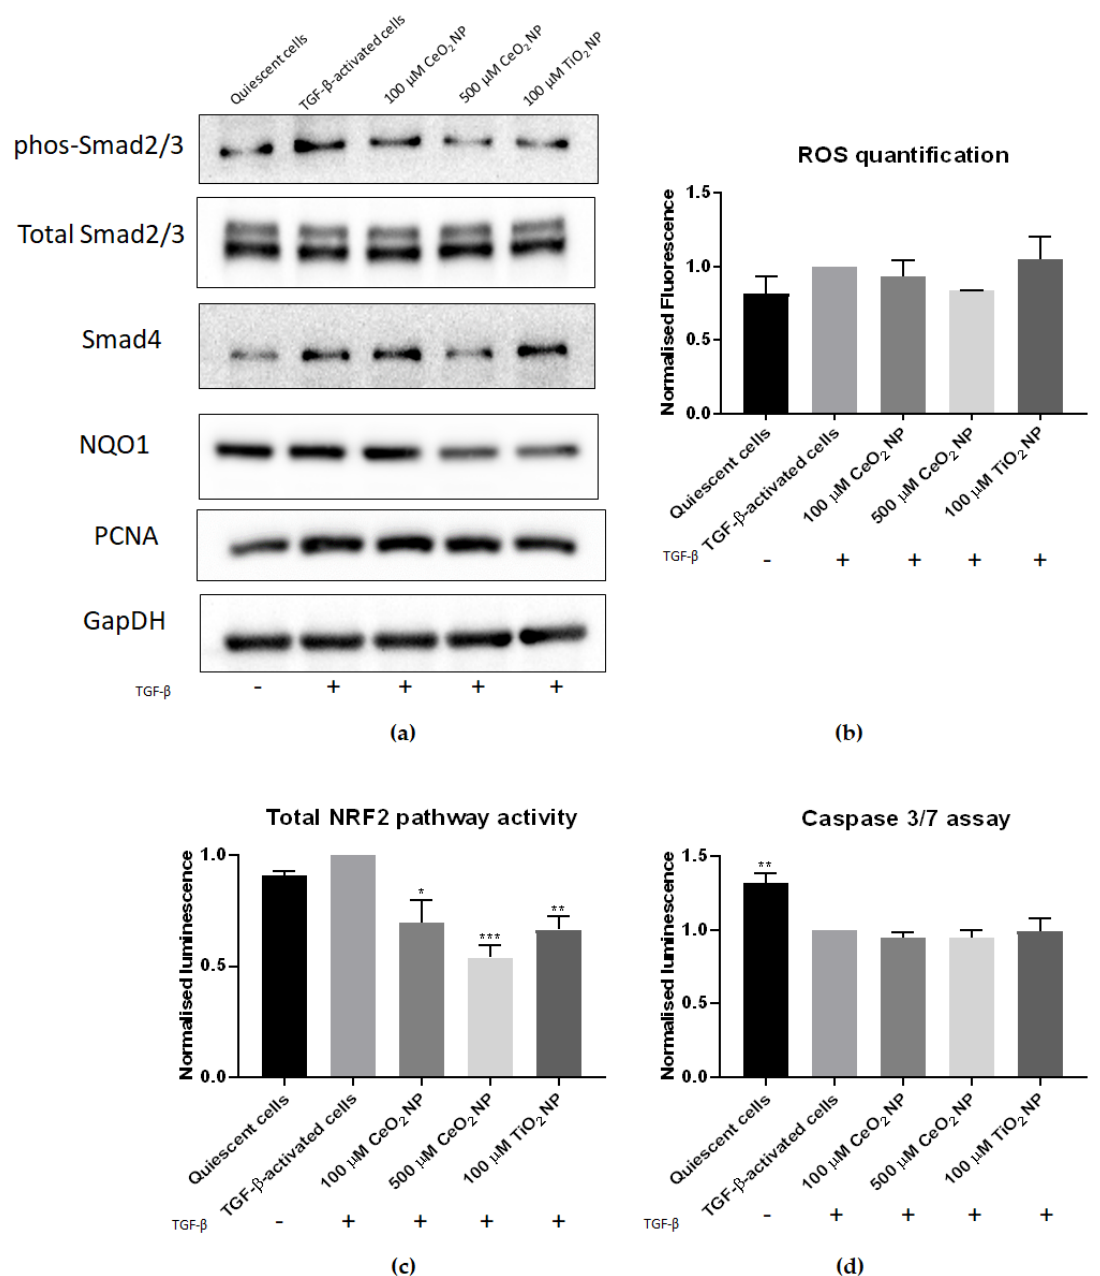
Figure 4. CeO 2 NP treatment reduces hallmarks of HSC activation. ( a ) Phosphorylated Smad2/3, total Smad2/3, Smad4 and NQO1 immunoblots. Phosphorylated Smad2/3 and Smad4 protein expression was decreased in 500 µ M CeO 2 NP-treated cells. Similarly, NQO1 expression was reduced in CeO 2 NP-treated cells. PCNA expression showed no difference between TGF- β controls and CeO 2 NP-treated samples. ( n = 4) ( b ) ROS levels in CeO 2 NP-treated cells were measured using flow cytometry. It can be seen that 500 µ M CeO 2 NP reduced oxidative stress to levels comparable to quiescent cell controls. ( n = 3) ( c ) Nrf2 pathway activity. Total Nrf2 activity was measured using an ARE-promoter assay. The 100 µ M CeO 2 NP, 500 µ M CeO 2 NP and TiO 2 NP-treated cells all showed significantly reduced Nrf2 activity. ( n = 3) ( d ) Caspase 3/7 activity assay. CeO 2 NP-treated cells showed no significant difference in caspase 3/7 activity compared to TGF- β controls. However, quiescent cells showed significantly higher caspase 3/7 activity. ( n = 3). Error bars represent SEM; ANOVA was used to calculate significance. * p < 0.05, ** p < 0.01, *** p <